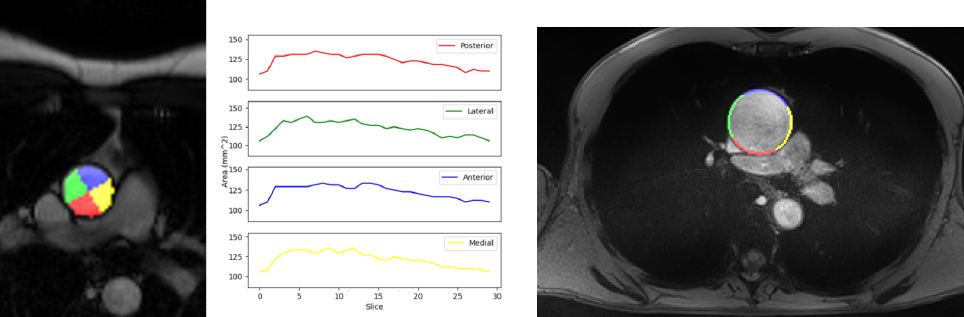
Figure 8. The left image is the division of the aorta into four quadrants with a rotation of 60 degrees. For each quadrant, the local compliance can be visualized thanks to the curve of the evolution of the surface area over time. The right image visualizes the perimeter per quadrant with different